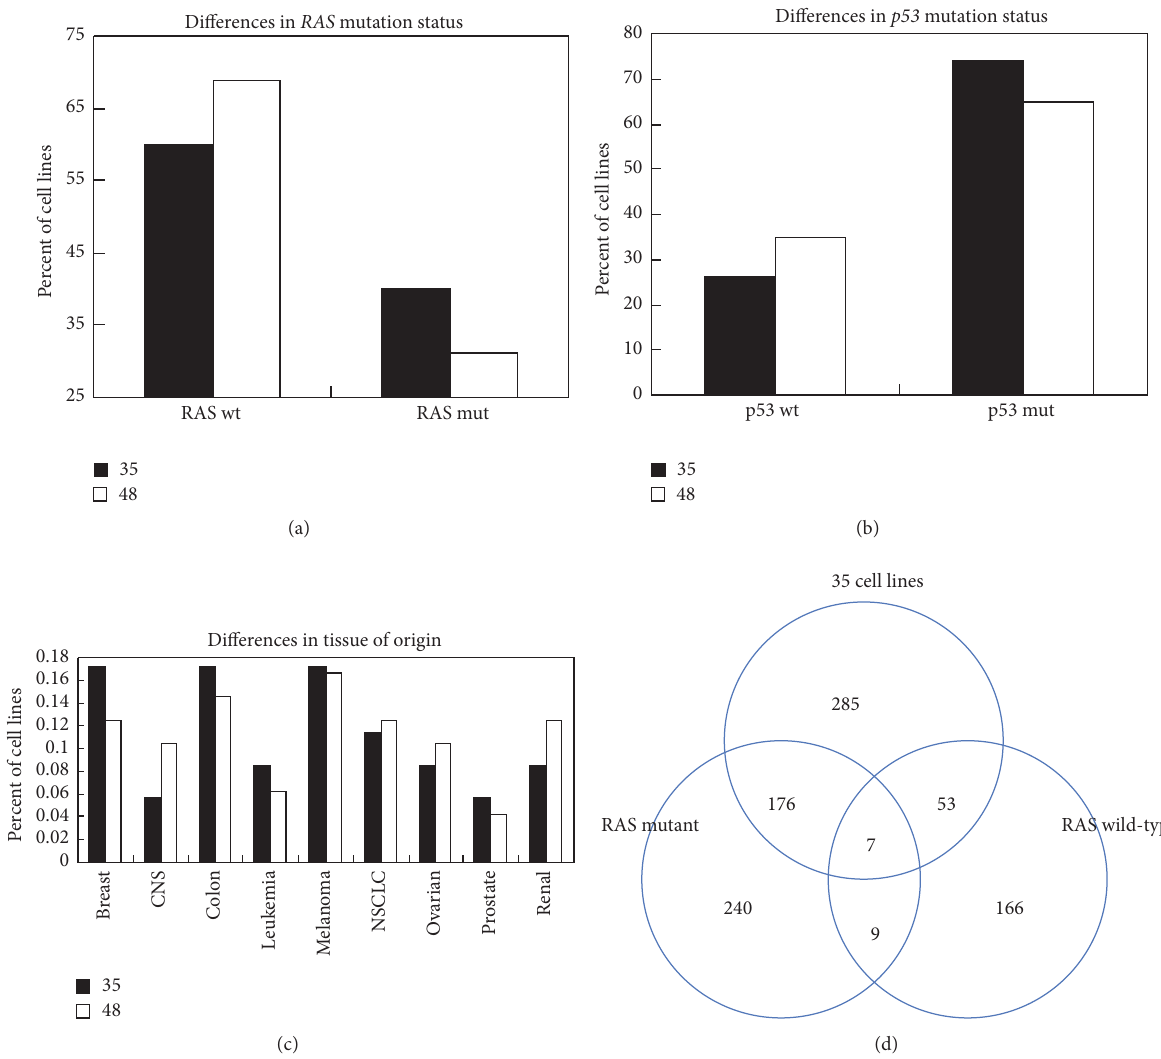
Figure 2: Biological characteristics differ when considering 35 cell lines versus an expanded set of 48 cell lines. (a) The proportion of RAS wild-type cell lines increased (60% to 69%). (b) The proportion of p53 wild-type cell lines increased (26% to 35%). (c) Tissue of origin of cell lines did not change significantly. (d) Venn diagram showing the lack of concordance in correlation when using a test for correlation ( 𝑝 < 0.05 ) using only RAS mutant or RAS wt cell lines in the 35-cell line set. Only 16 probesets were found correlated in both